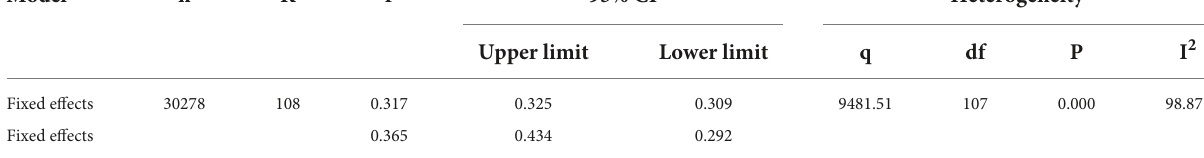
FIGURE3 Funnel plot.